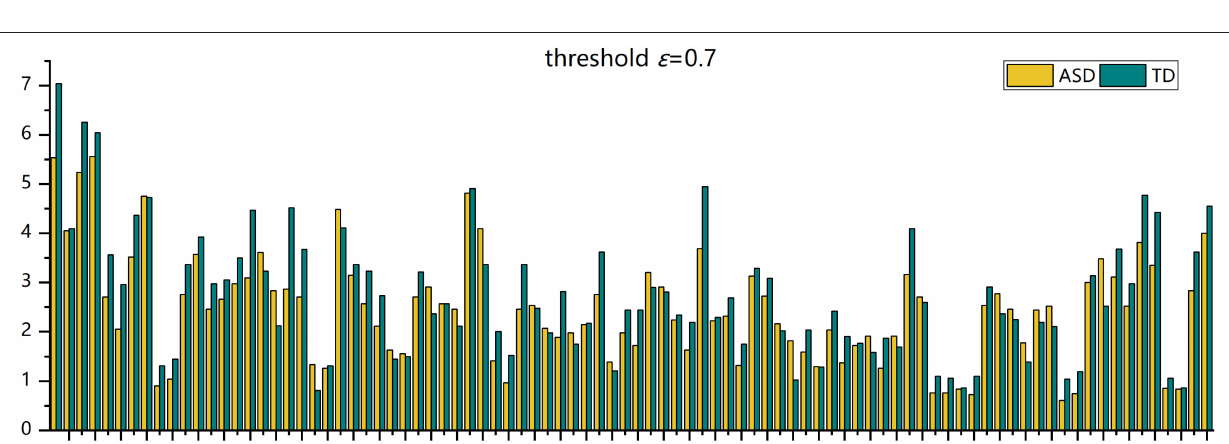
FIGURE 5 | Comparison of the FC neural circuits in the ASD brain network (left) and the TD brain network (right) at a threshold value of 0.7. The abbreviations for names of brain regions in the AAL atlas are listed in the Supplementary Material . The differences of the colors of edges are just for easy to observe.